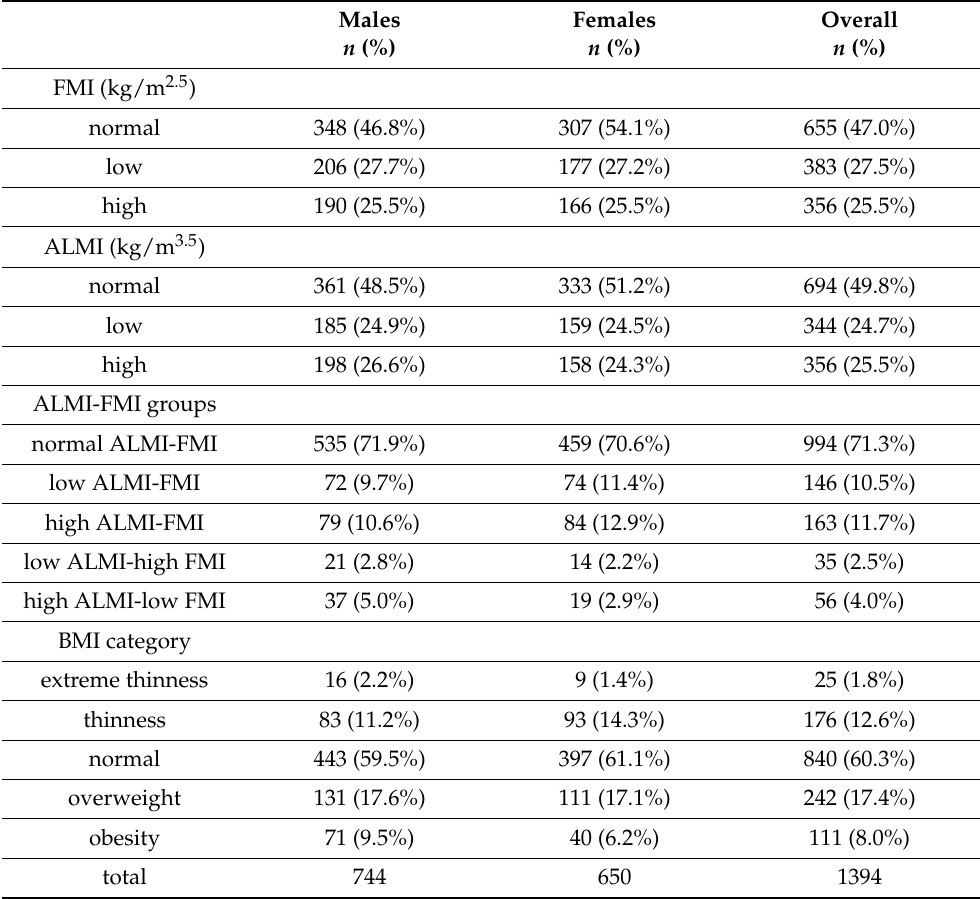
Table 1. Sample size and prevalence of body composition groups and BMI